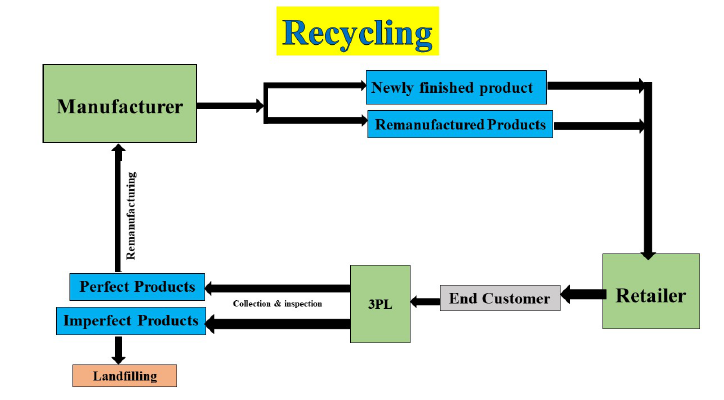
Figure 2. CLSCM diagram for